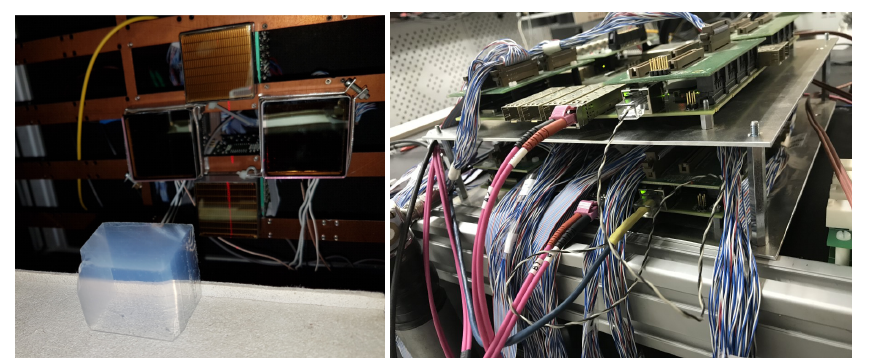
Figure 3. Photograph of the FARICH-3 prototype’s MaPMTs and MCP PMTs (left) and TRB3 boards (right).